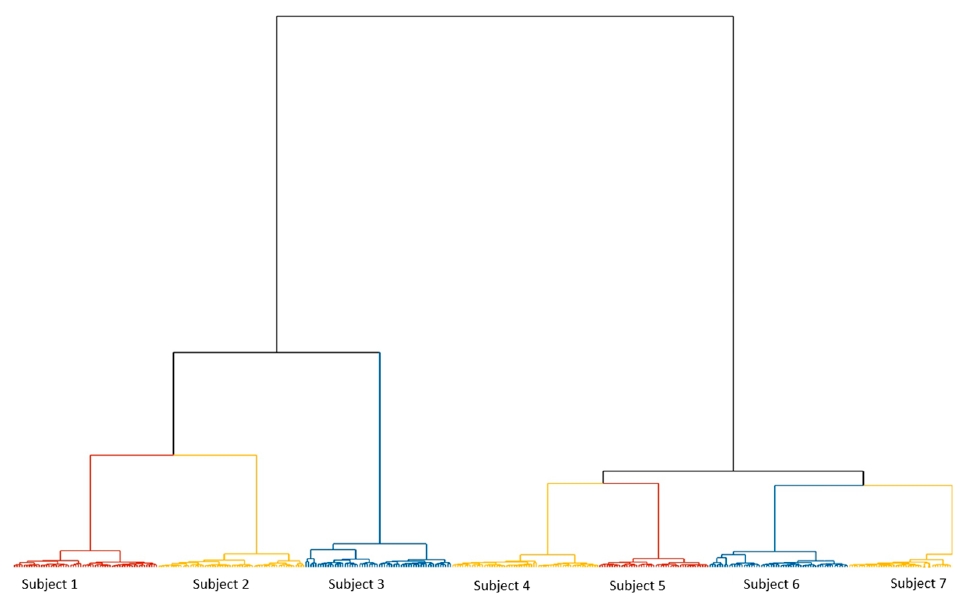
Figure 2. Dendrogram of the cluster analysis including all throws of all subjects (n = 395).